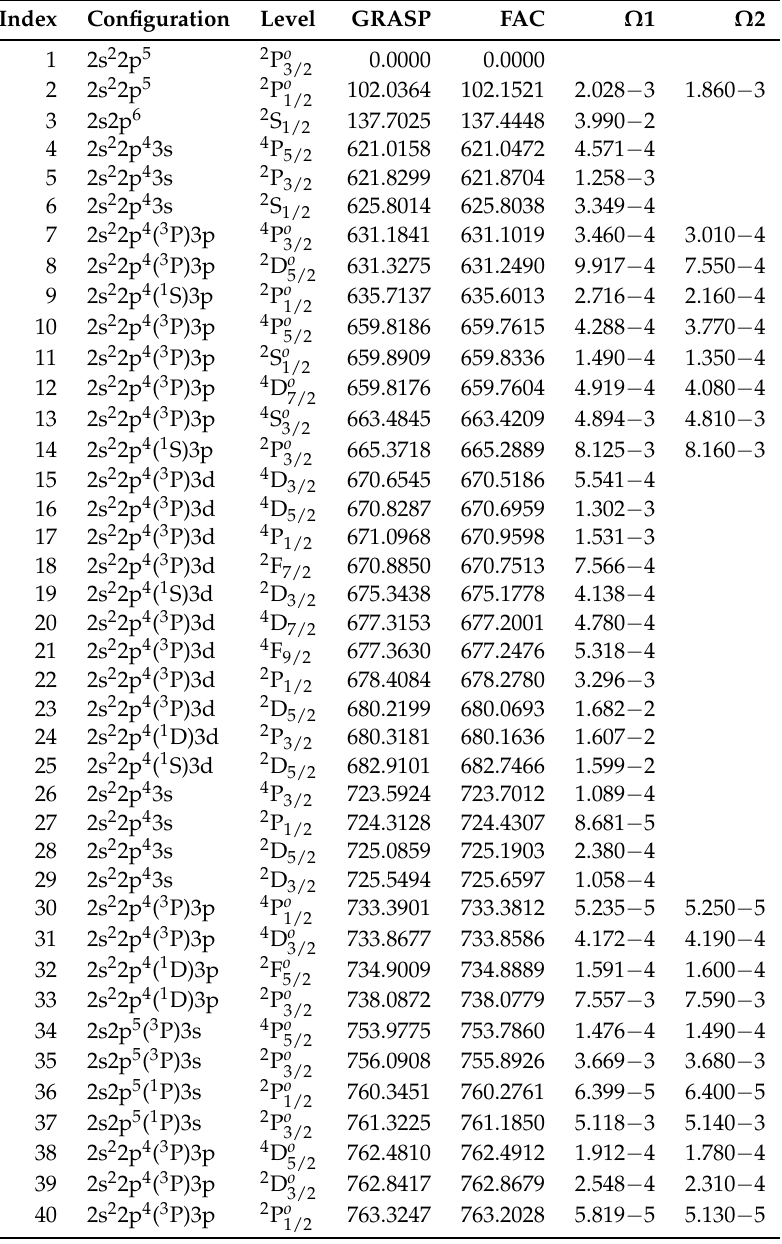
Table 1. Comparison of GRASP and FAC energies (in Ryd) for the levels of W LXVI, and collision strengths ( Ω ) for the resonance transitions at an energy of 1600 Ryd. a ± b ≡ a × 10 ± b